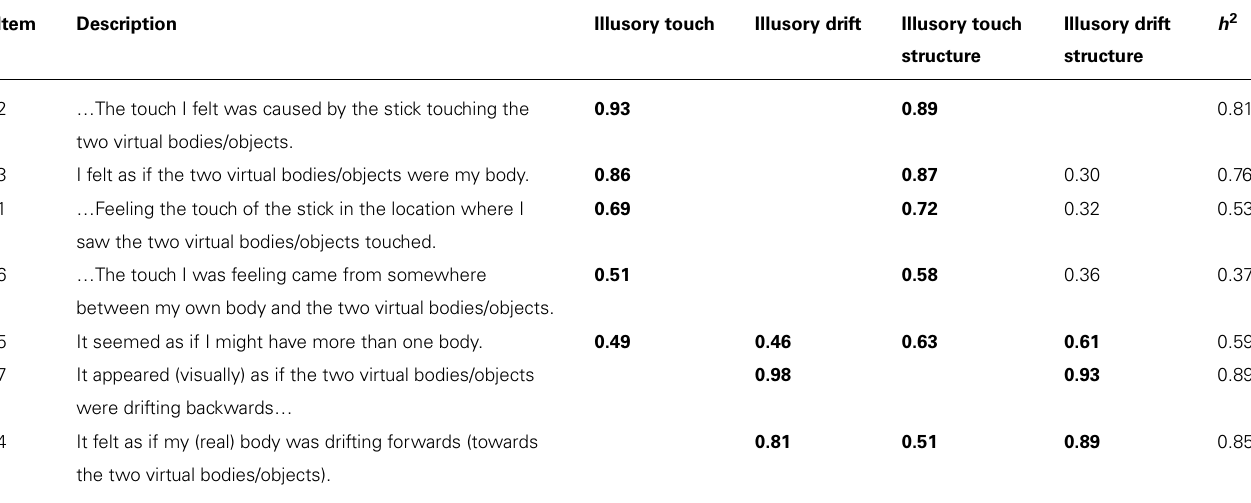
Table 2 | Principal component